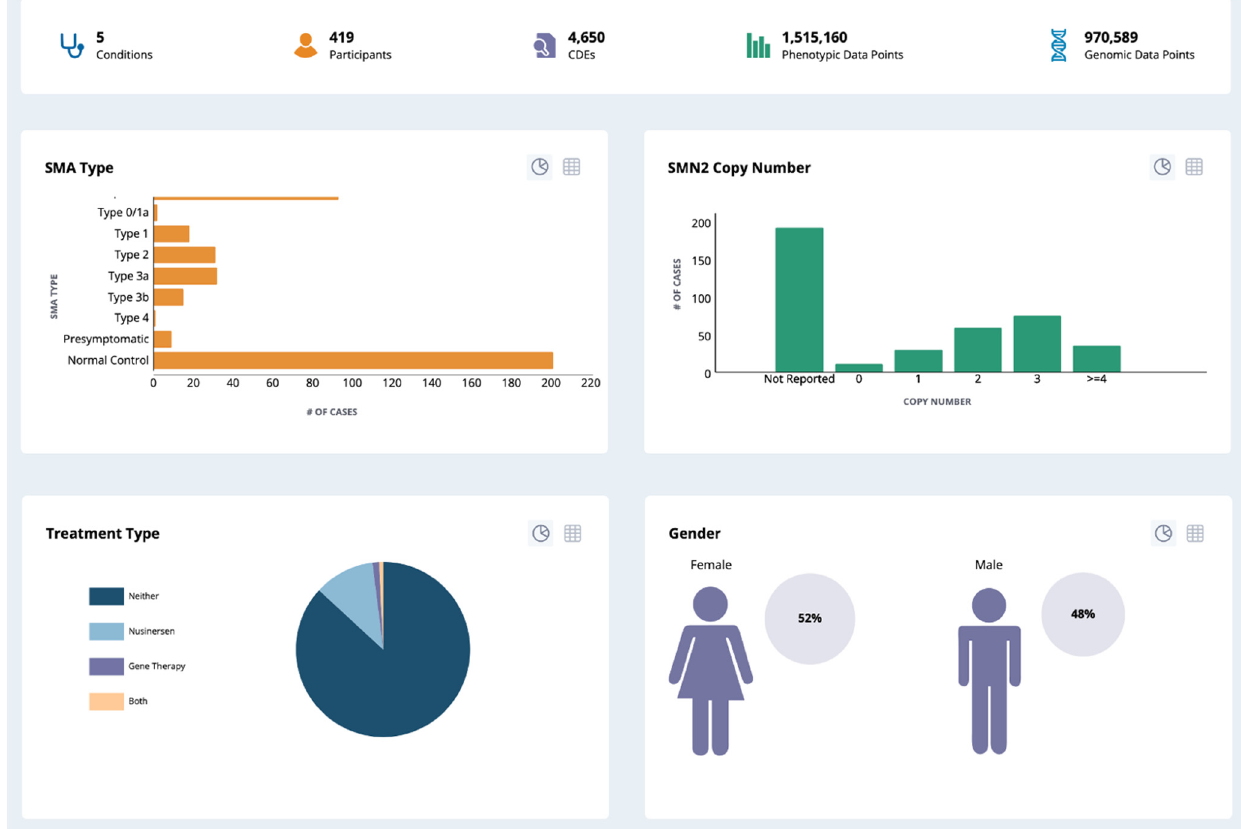
Figure 4. LPDR Data Visualization.